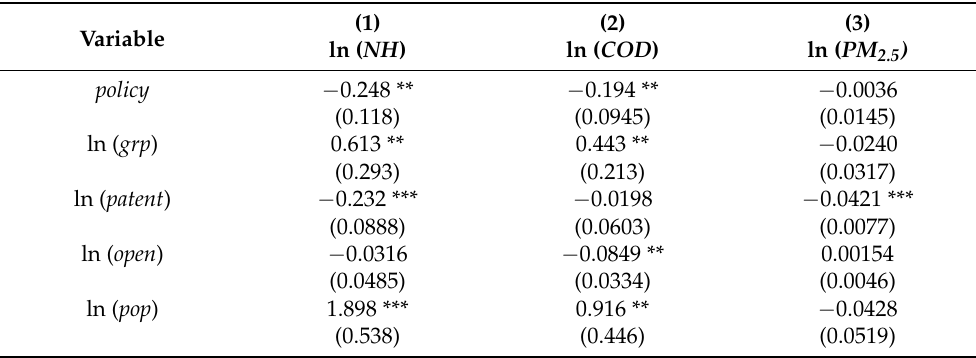
Table A1. Effect of the policy on other pollution